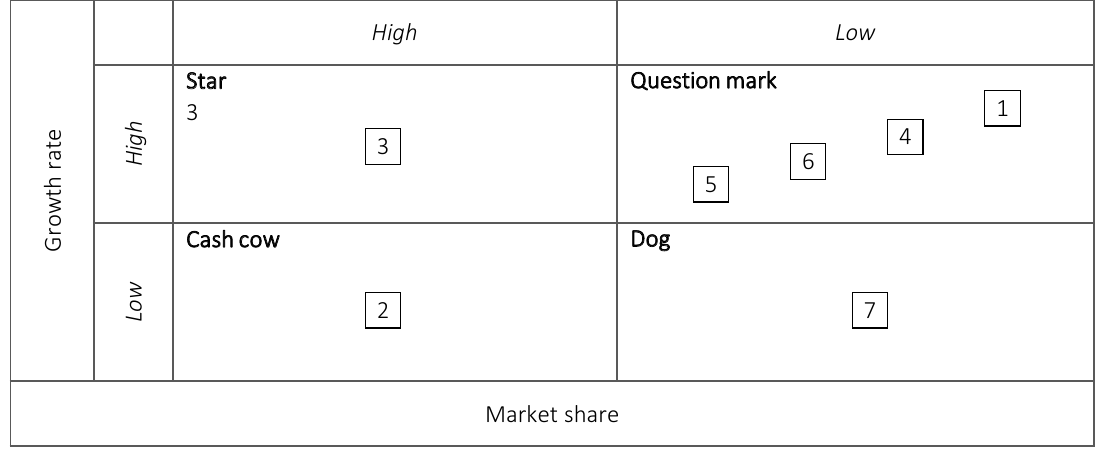
Figure 3. Growth-share